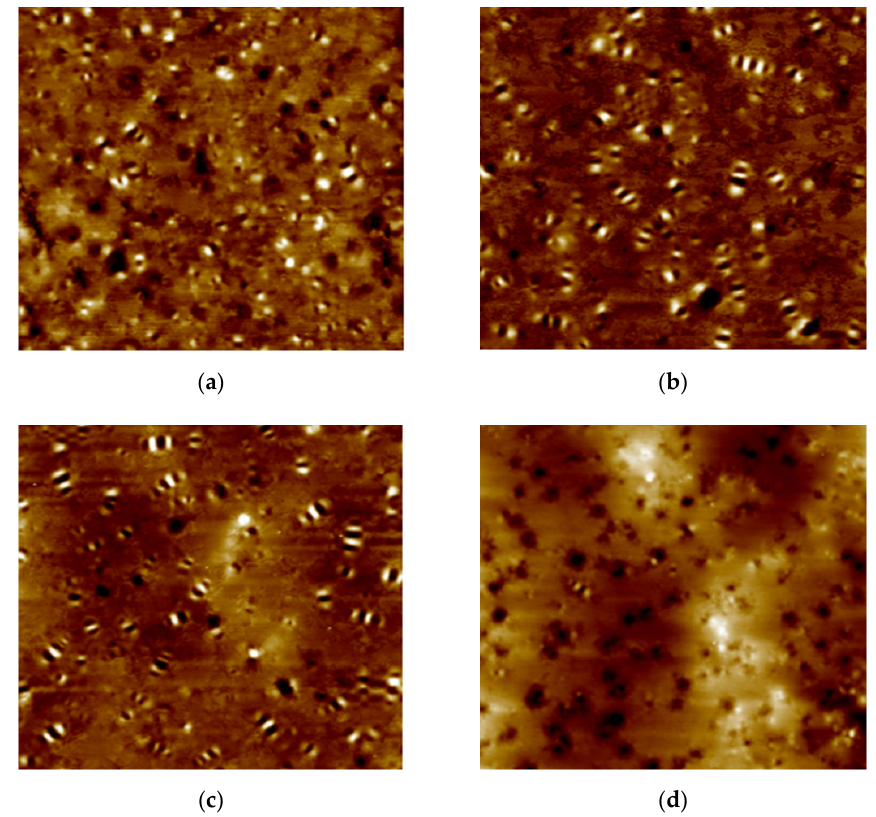
Figure 4. AFM images of TB rubberized asphalt ( a ) Control binder; ( b ) 0.5% Nano ‐ SiO 2 ; ( c ) 1.5% Nano ‐ SiO 2 ; ( d ) 3% Nano ‐ SiO 2 .